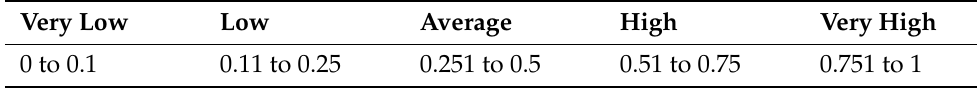
Table 1. Quantitative values of intensity levels for All Factors. Very Low Low Average High Very High 0 to